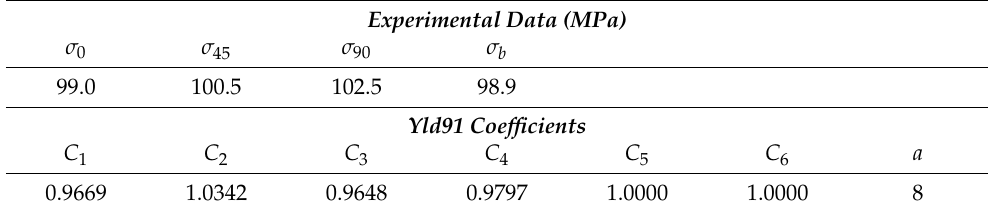
Table 3. Anisotropy coefficients of AA5754. Adapted from Ref. [33] with permission from Elsevier